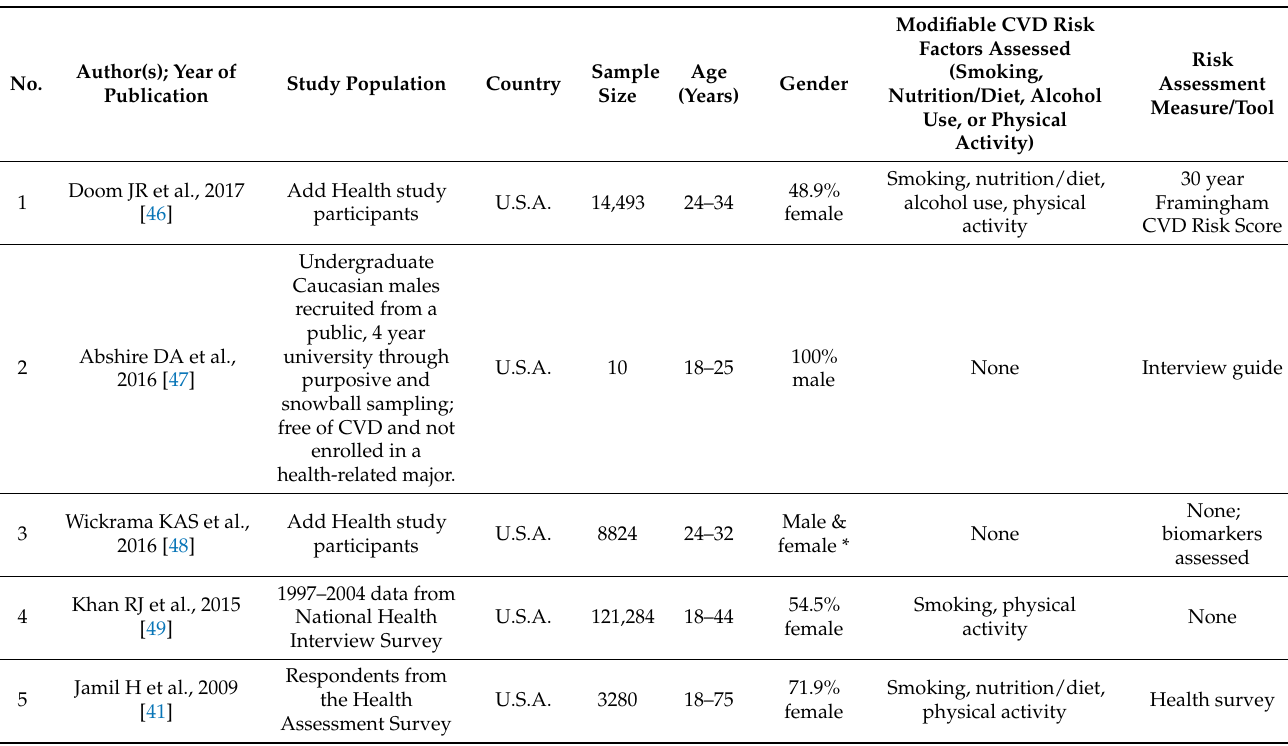
Table 4. Summary of included studies that assessed CVD risk in underserved young adult